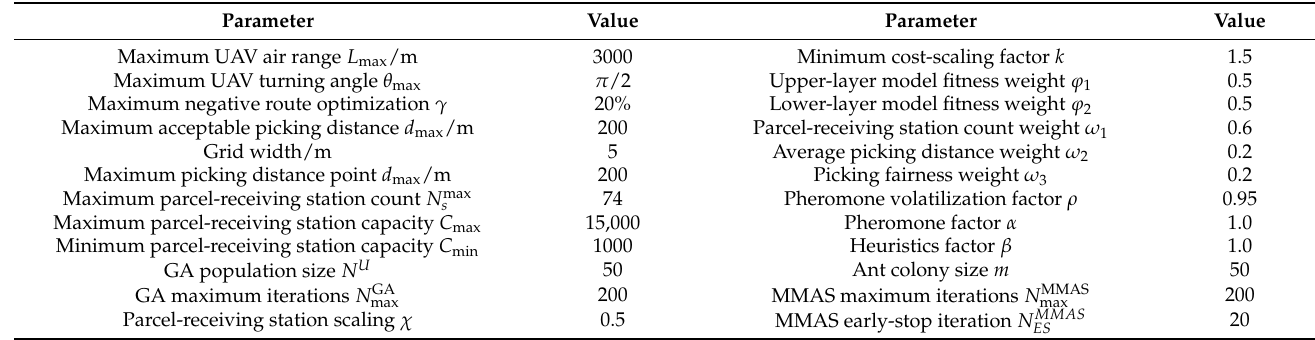
Table 6. Simulation parameter settings.